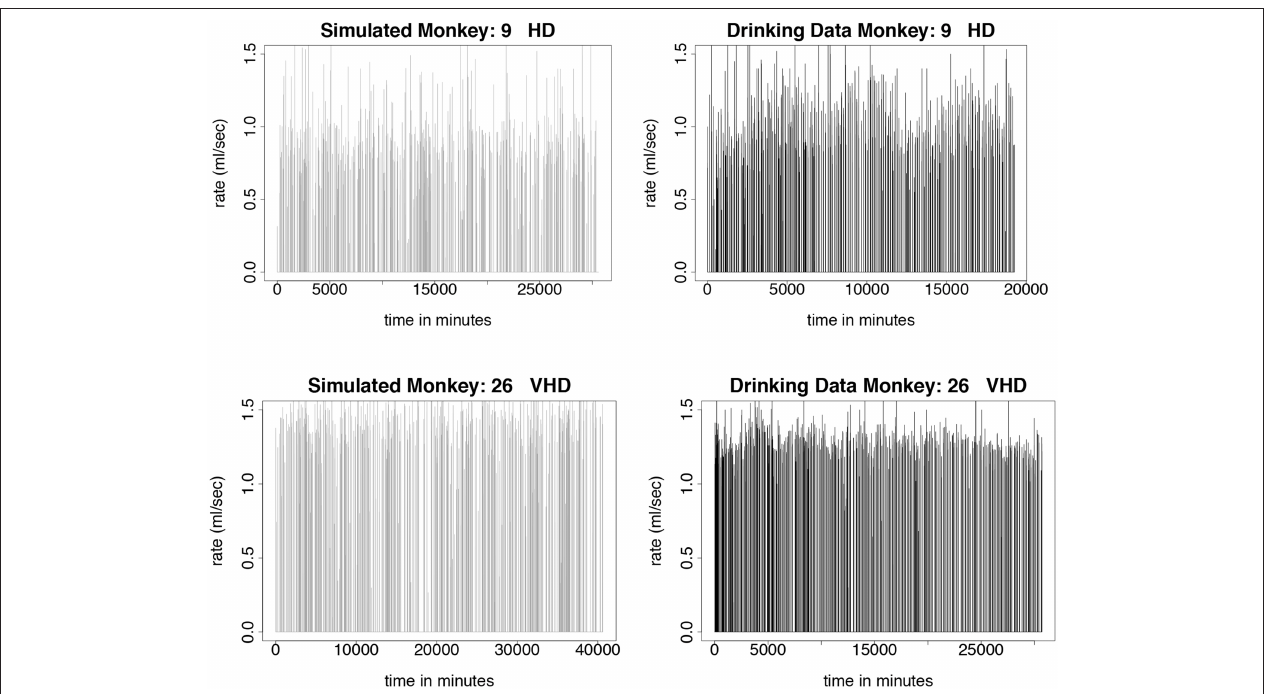
FIGURE 6 | Time series plots comparing simulated drinking data compared to actual drinking data for heavy and very heavy drinkers is shown in this figure. The simulations are qualitatively the same as the data. Instead of sipping like the light drinkers, the heavy drinkers take more gulps as demonstrated by the higher rates of consumption. Normally distributed noise was added to the simulated values in order to more closely resemble the drinking data. The simulation was run for 180 days, where each day consists only of 7 h of daytime drinking. We use 750 drinks from 12 months of daytime drinking (7 h) in the drinking data figures. (Upper Left) Simulated drinking data for a heavy drinker. (Upper Right) Actual drinking data for a heavy drinker. (Lower Left) Simulated drinking data for a very heavy drinker. (Lower Right) Drinking data for a very heavy